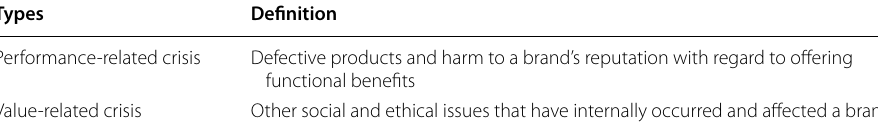
Table 2 Types of brand crises (Summarized by authors based on Dutta & Pullig, 2011)